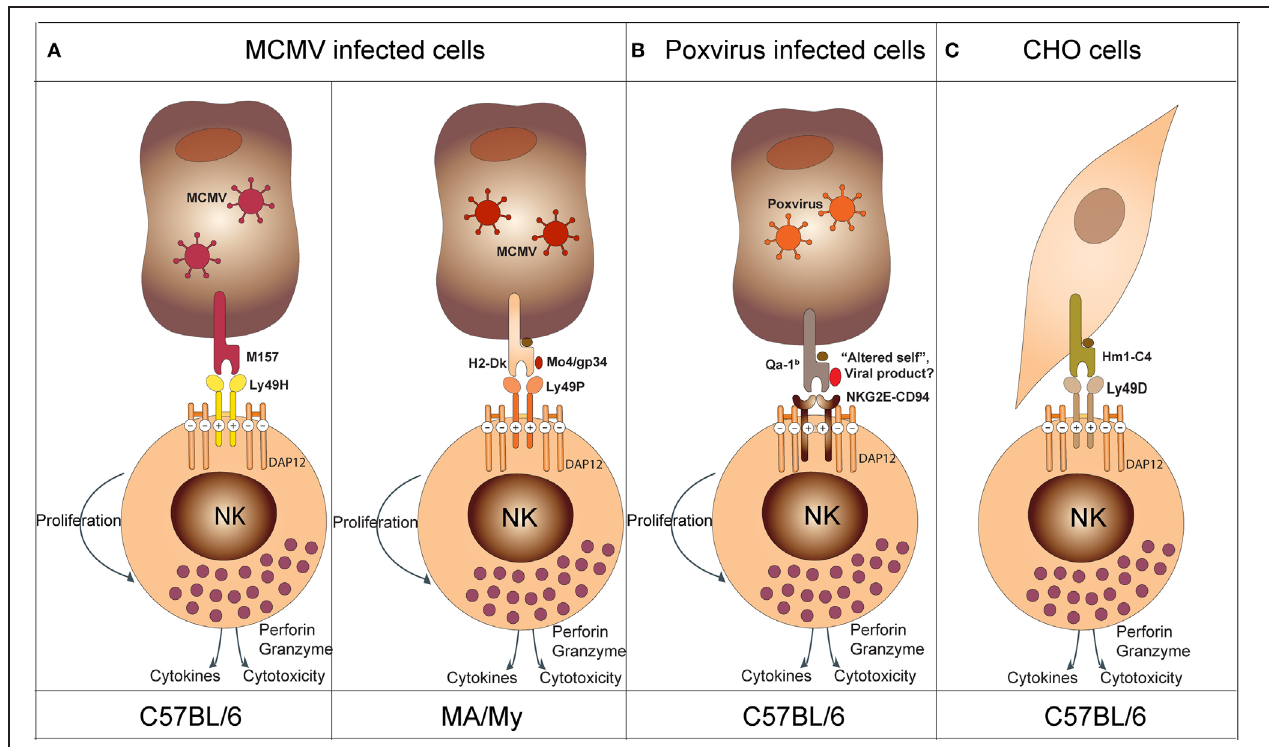
FIGURE 4 | Model depicting NK cell recognition of target cells. (A) In the context of MCMV infection, Ly49H (in C57BL/6 mice) recognizes the viral product M157 and Ly49P (in MA/My mice) recognizes the viral product M04/gp34 in association with H2-D k . (B) In the context of poxvirus infection, NKG2E-CD94 recognizes an “altered self” or a viral